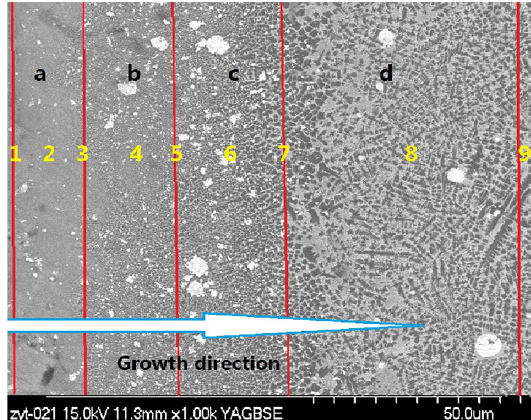
O /ZrO hypoeutectic 2 3 2